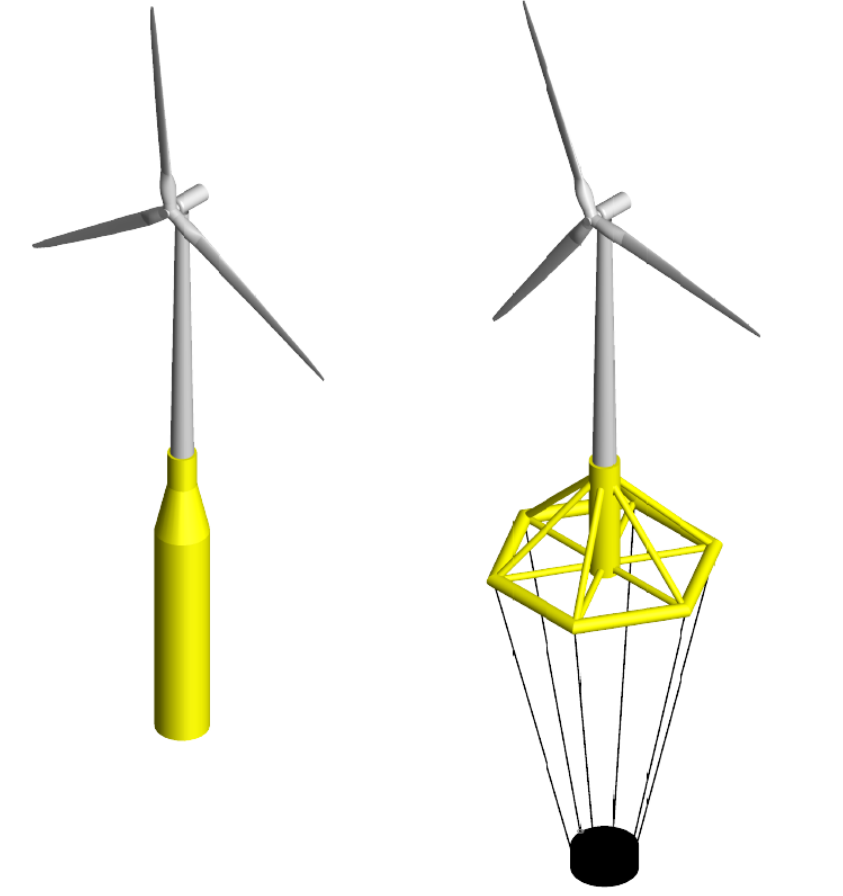
Figure 16. Complete CAD models (spar-buoy on the left , hexafloat on the right ). Observing the energy needs of Pantelleria, it was planned to design a wind farm including 5 turbines of 5